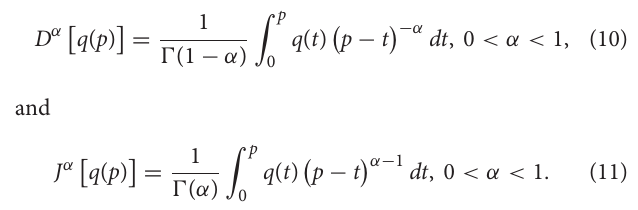
where Ŵ is the shear stress tensor, λ i ( i = 1, 2, 3 ) are constitutive parameters, α and β are the fractional derivative and integral defined as Hilfer